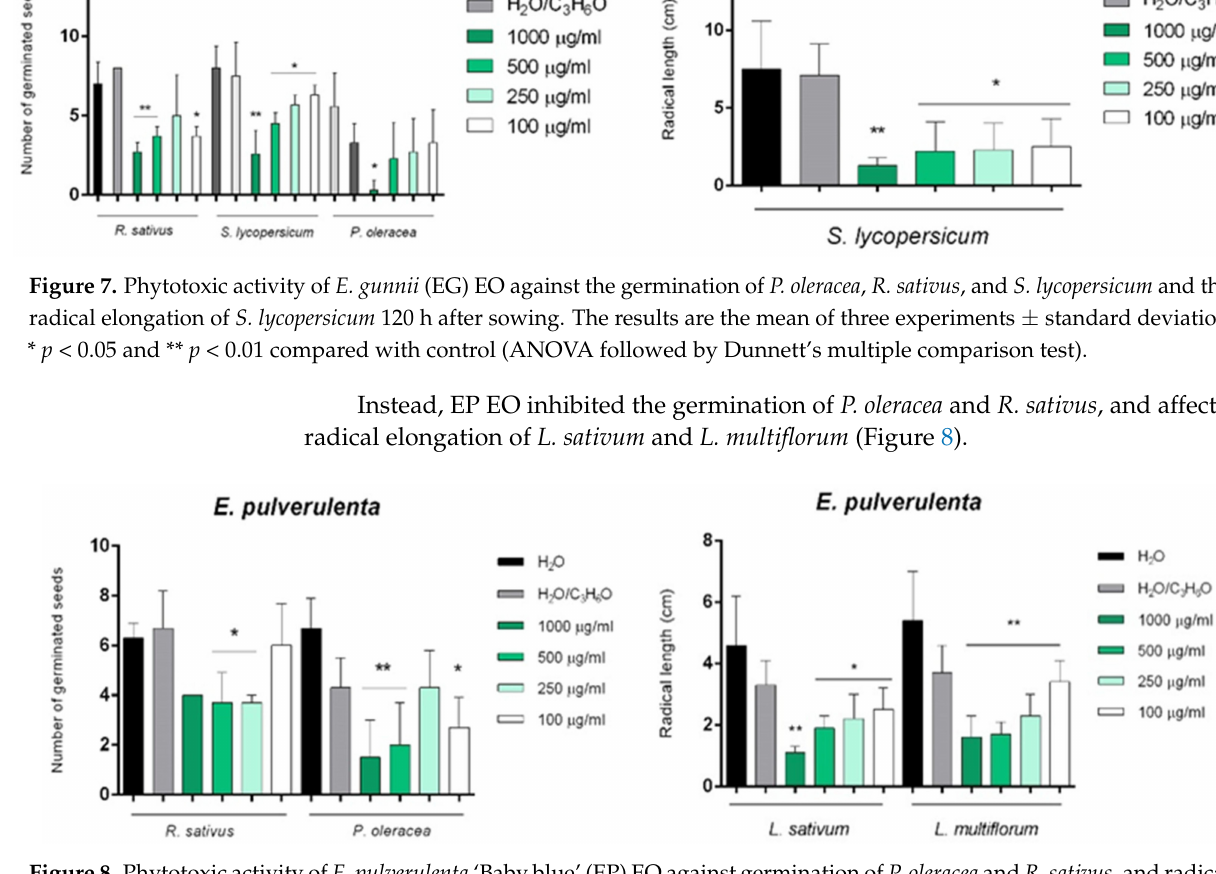
Figure 8. Phytotoxic activity of E. pulverulenta ‘Baby blue’ (EP) EO against germination of P. oleracea and R. sativus , and radical elongation of L. sativum and L. multiflorum 120 h after sowing. The results are the mean of three experiments ± standard deviation. * p < 0.05 and ** p < 0.01 compared with control (ANOVA followed by Dunnett’s multiple comparison